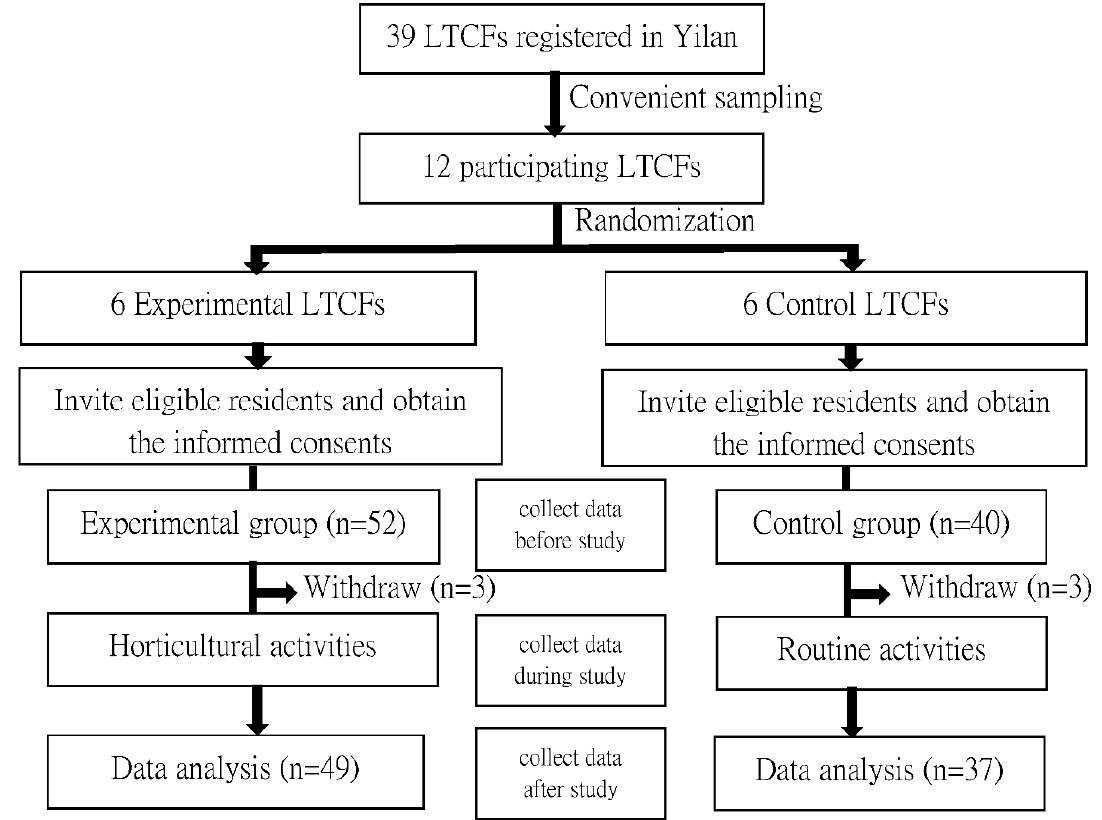
Figure 1. Flowchart of participant recruitment and program implementation.